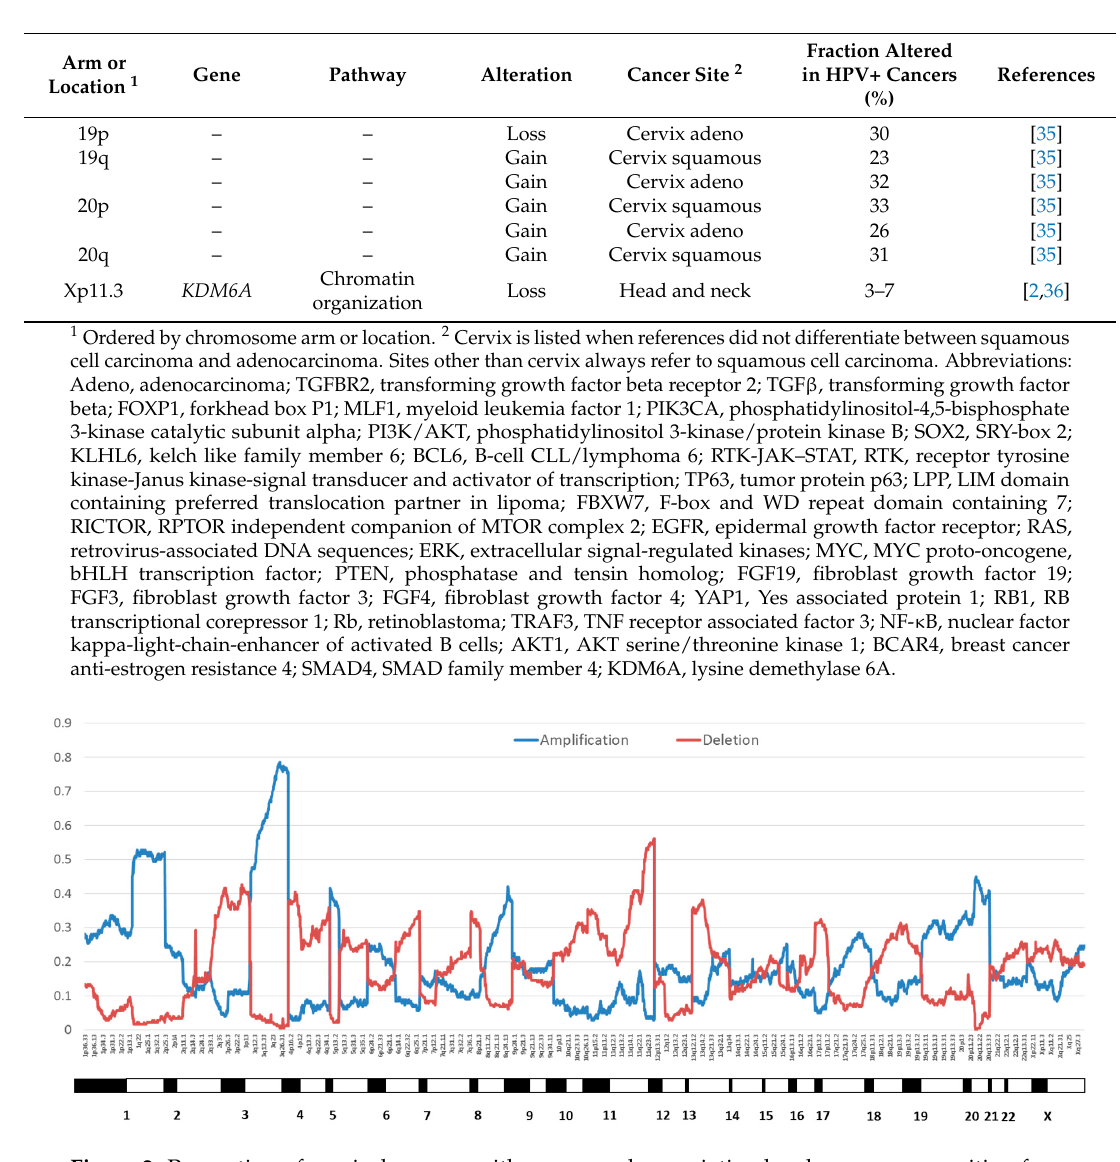
Figure 2. Proportion of cervical cancers with copy number variation by chromosome position from The Cancer Genome Atlas (TCGA) cervical cancer data [18]. Amplifications are in blue and deletions are in red.